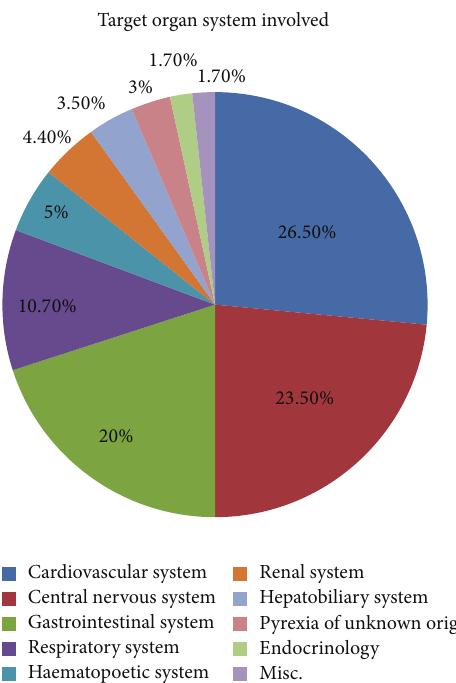
Figure 1: Pie chart showing the distribution of various target organ systems